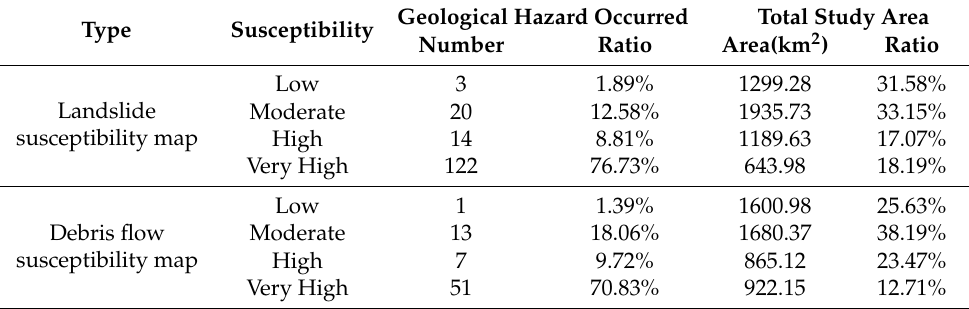
Table 8. Statistical results of the geological hazard-susceptibility